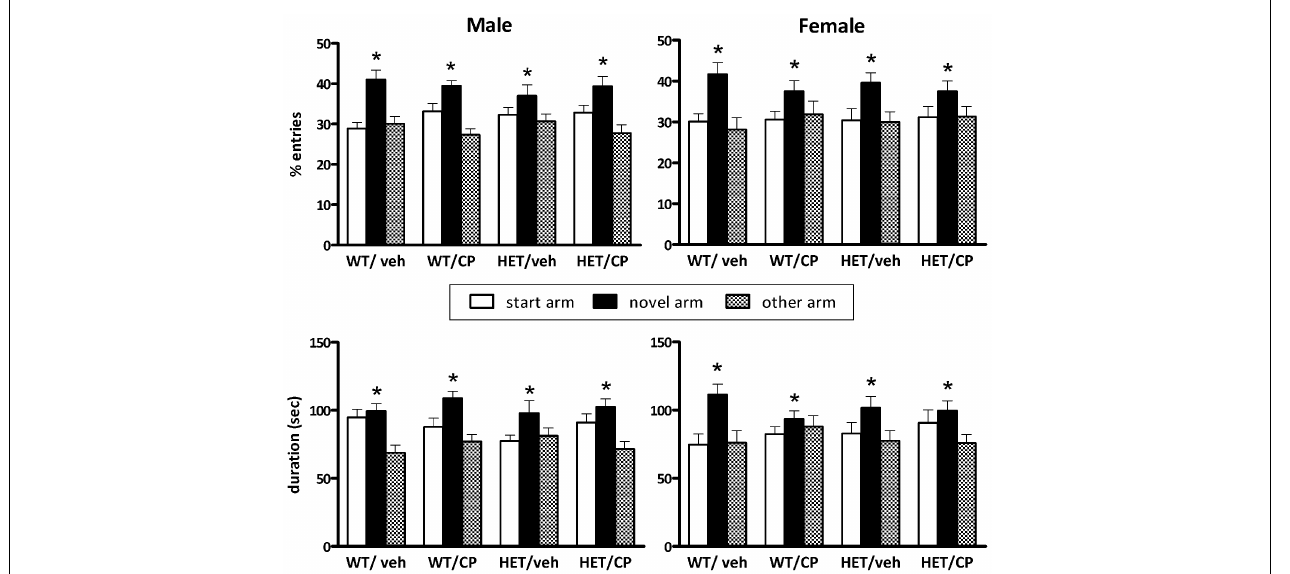
FIGURE 2 | Y-maze behavior after a 2h retention period of BDNF heterozygous (HET) and wild-type (WT) mice treated with vehicle (veh) or CP55,940 (CP). ( Top) show the percentage number of entries into the start, novel and “other” arm of the Y-maze during the 5min re-exposure session and the ( Bottom) show the duration of time spent in